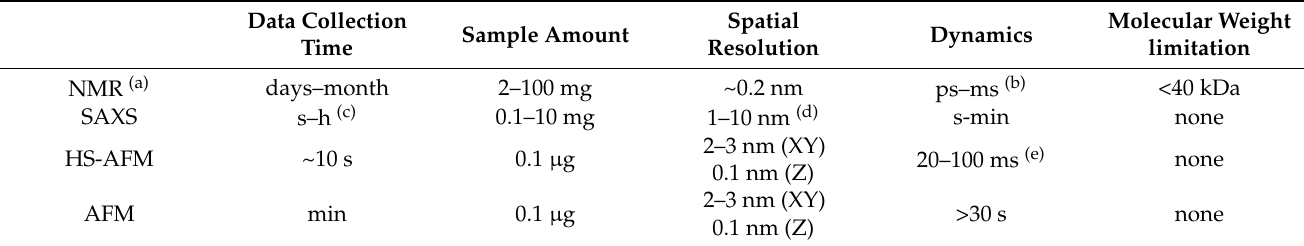
Table 1. Comparison of four techniques used in structural analysis of